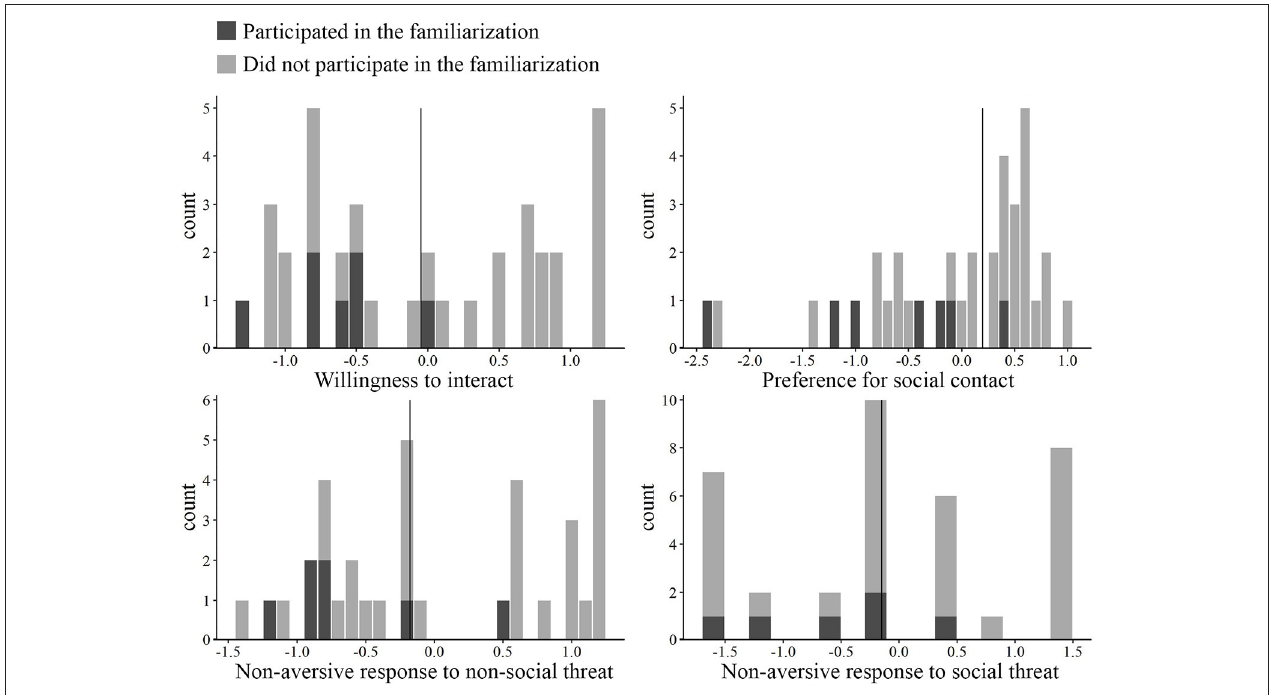
FIGURE 1 | Histograms of the four components during the placebo treatment condition. Vertical lines represent the median that was used as the threshold for dividing the dogs into high and low groups ( N = 18 in all groups). Dogs that participated in the familiarization are marked with dark gray.